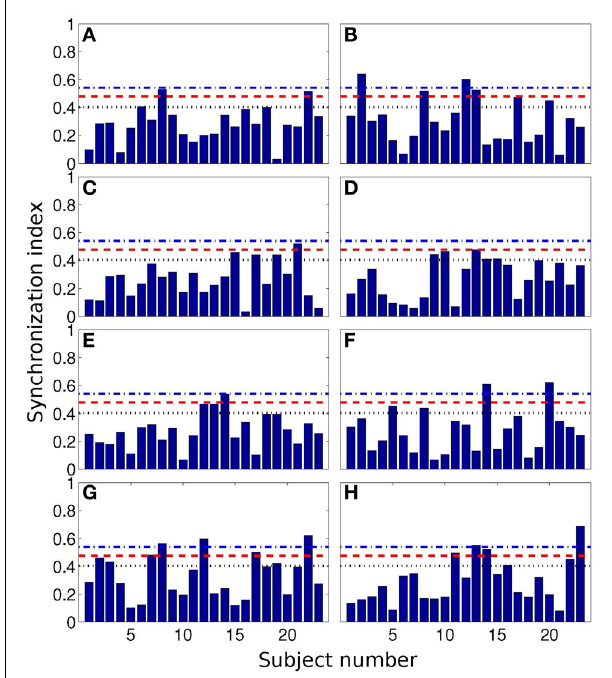
FIGURE 4 | Synchronization index of the RE response for all 23 participants and for different interval durations: 0.5s (A), 2s (B), 3s (C), 7s (D), 10s (E), 14s (F), 25s (G), and 40s (H). Horizontal blue dash-dotted line, red dashed line, and black dotted line show 5, 10, and 20% quantile thresholds,